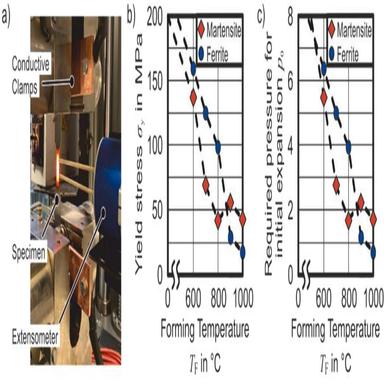
a) Implemented setup of the hot tensile test, b) yield stress σ0 and c) resulting required pressure for initial expanding p0 depending on the temperature to begin the expansion process of the tubular materials.